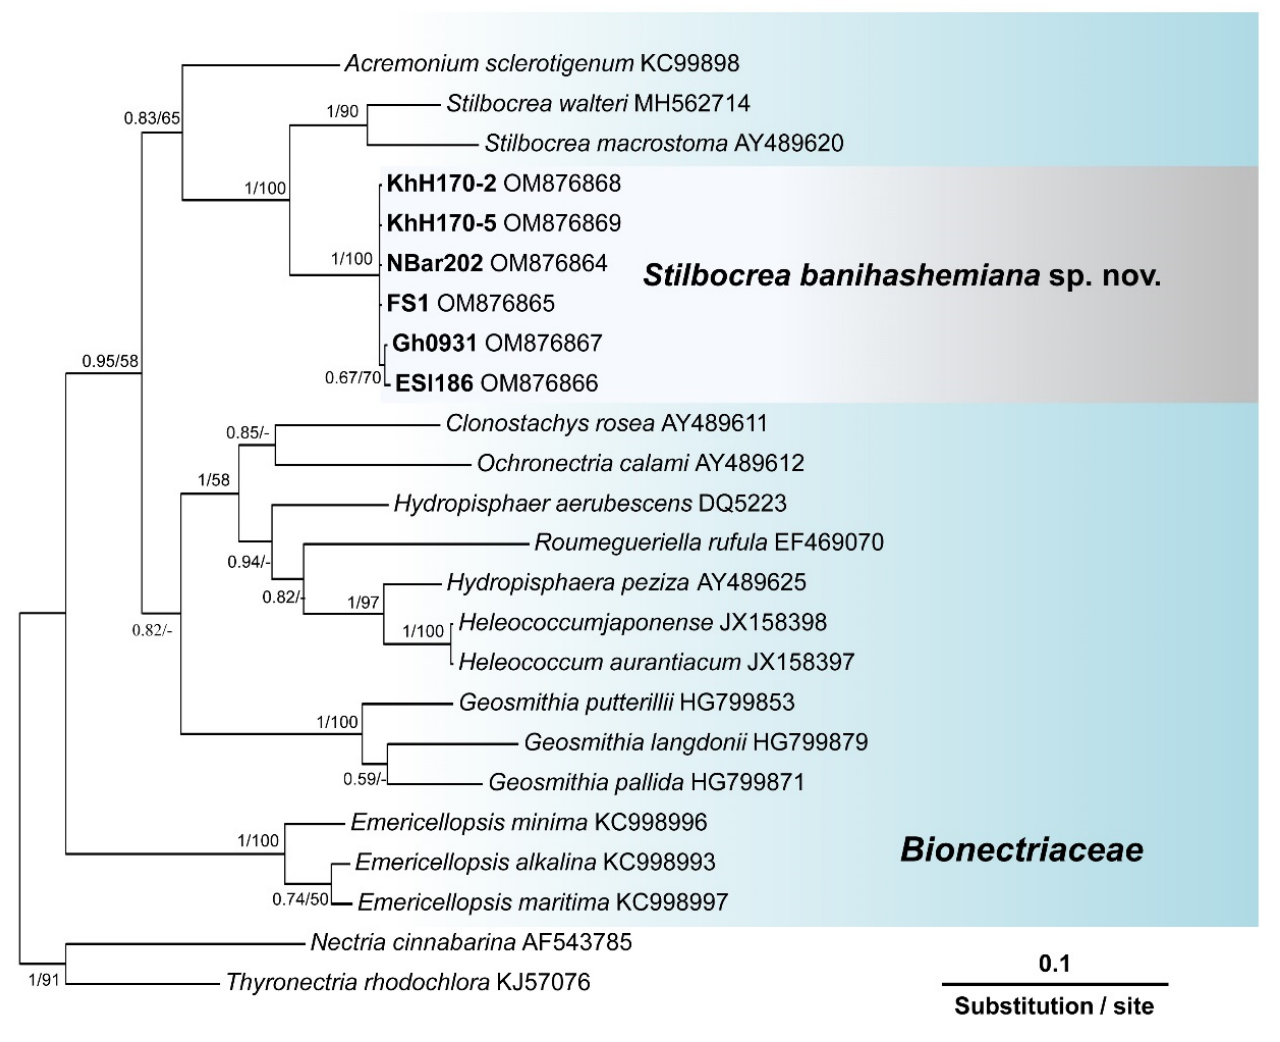
Figure 3. Phylogenetic position of Stilbocrea banihashemiana sp. nov. from infected fig and loquat trees sampled in Fars Province, Iran within Bionectriaceae : relationships among 16 Bionectriaceae members based on Bayesian analysis of tef1 (translation elongation factor 1- α ) sequences. Isolates in bold were sequenced in the present study. Numbers on the nodes are Bayesian posterior probability values (BI–PP) followed by maximum likelihood bootstrap values (ML–BS) and fully supported branches (BI–PP = 1/ML–BS = 100). The tree was rooted to Nectria cinnabarina ( Necriaceae ). FS1 = ex-type = CBS 148864. Isolates recovered from infected fig, and loquat trees in Iran are indicated in bold .